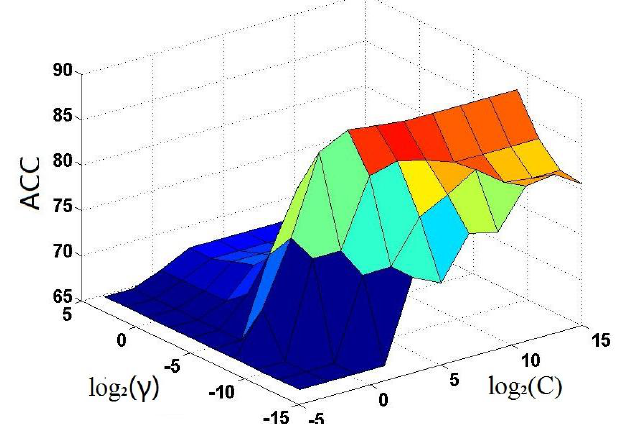
Figure 3. A 3-D graph showing how to optimize the two parameters  and C in SVM via the jackknife success